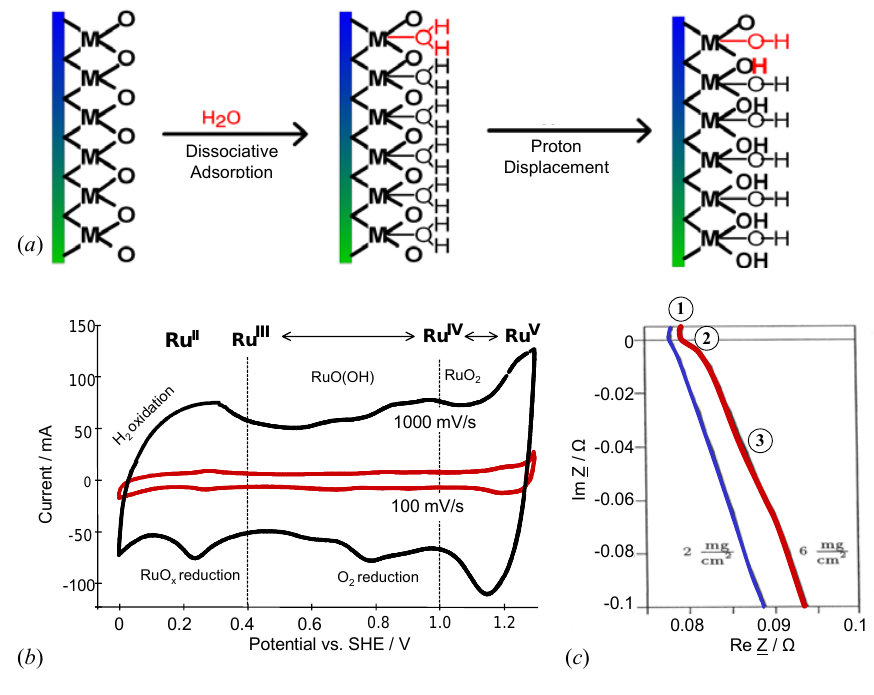
Figure 3. (a) Dissociative adsorption of water at platinum metal oxides and proton conduc- [Ru]OH − + H + [Ru]O 2 − + 2H + . (b) Cyclic voltammogram of a tivity [38]: [Ru]OH 2 electrode in sulfuric acid (3 mol/L) at different scan rates. Standard potentials: RuO 2 (1.4 V). (c) Increase of ac Ru 3+ /Ru 2+ (0.24 V), Ru IV /Ru 3+ (0.86 V), Ru IV /RuO 4